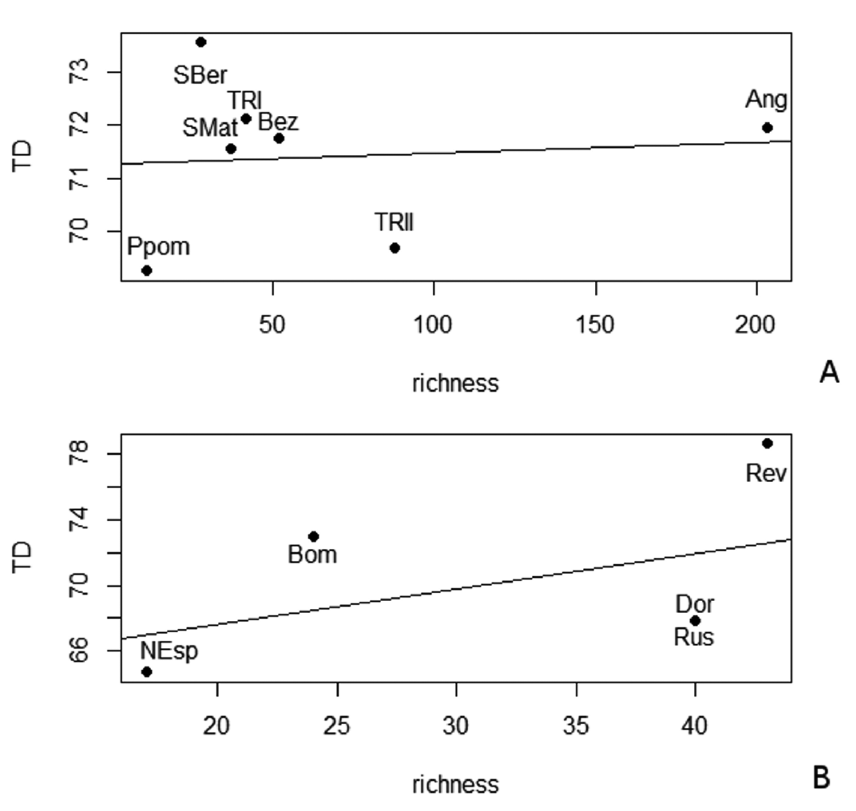
Figure 6. Simple linear regression between richness and Taxonomic distinctness (TD) values of caves from A São Domingos and B Posse karst areas. Legend: SBer= São Bernardo cave system, Ang= Lapa Angélica, Bez= Lapa do Bezerra, SMat= São Mateus cave system, TR_I= Terra Ronca I cave, TR_II= Terra Ronca II cave, PPom= Pau Pombo cave, Rus= Russão cave system, Bom= Bombas cave system, Dor= Doralino cave system, NEsp= Nova Esperança cave, Rev= Revolucionários